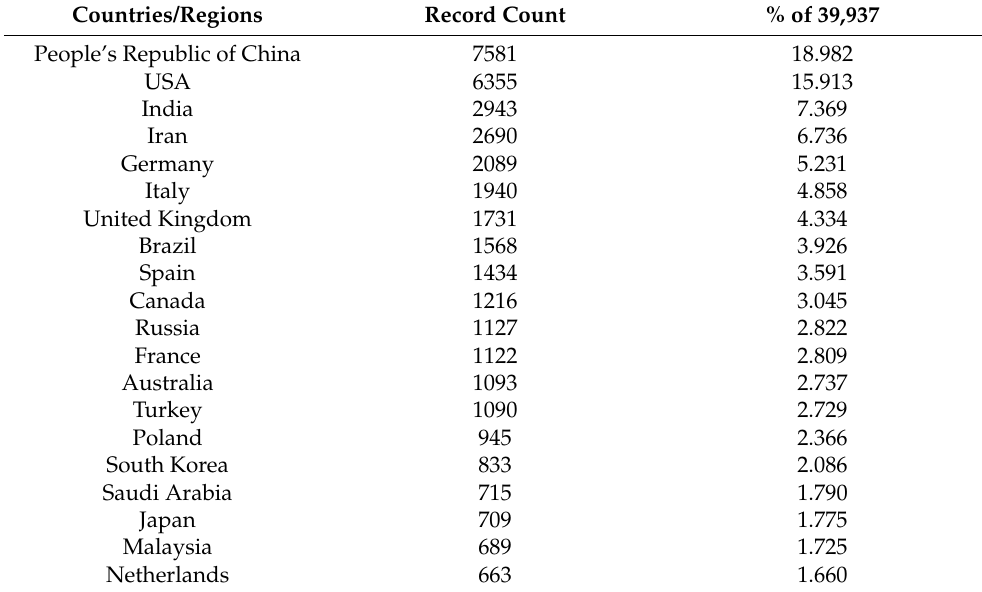
Table 12. Top 20 Countries based on the number of publications (2019–2021).